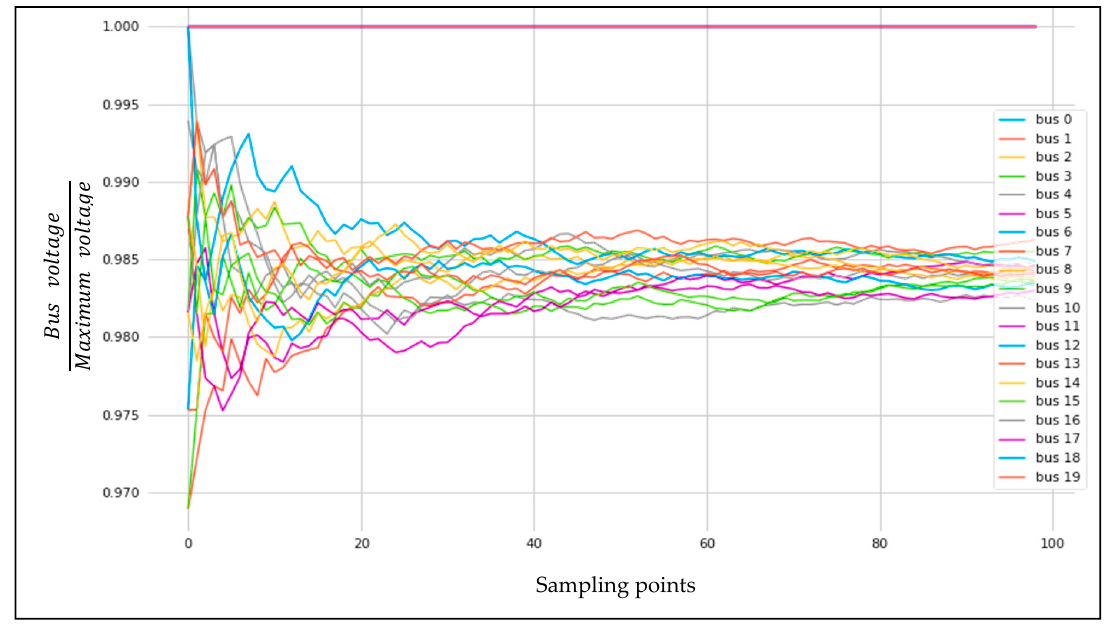
Figure 17. Latin hypercube TO bus voltage average for NASA N3-X.